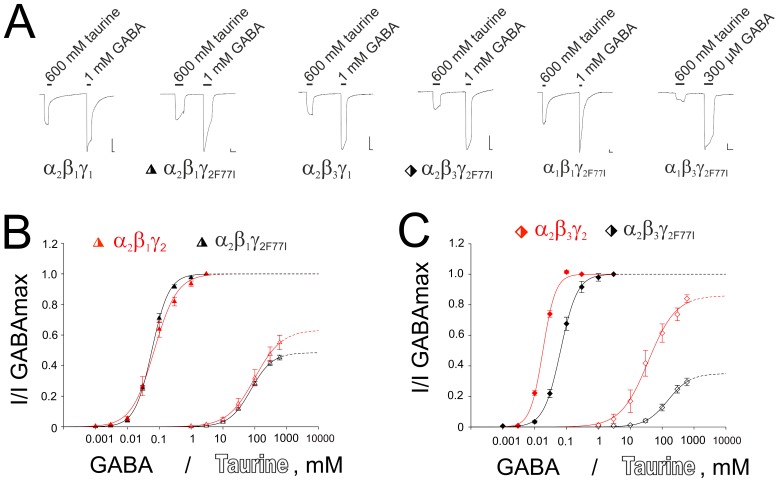
Mutation γ2F77I reduces taurine efficacy at recombinant GABAA receptors.(A) Representative current traces show responses to the maximal GABA and taurine concentrations at different receptor types. For two representative receptor types (marked with symbols) concentration-response plots for GABA (filled symbols) and taurine (open symbols) are shown in (B) and (C). Data obtained in corresponding wild type receptors (γ2 instead of γ2F77I) are plotted in red.